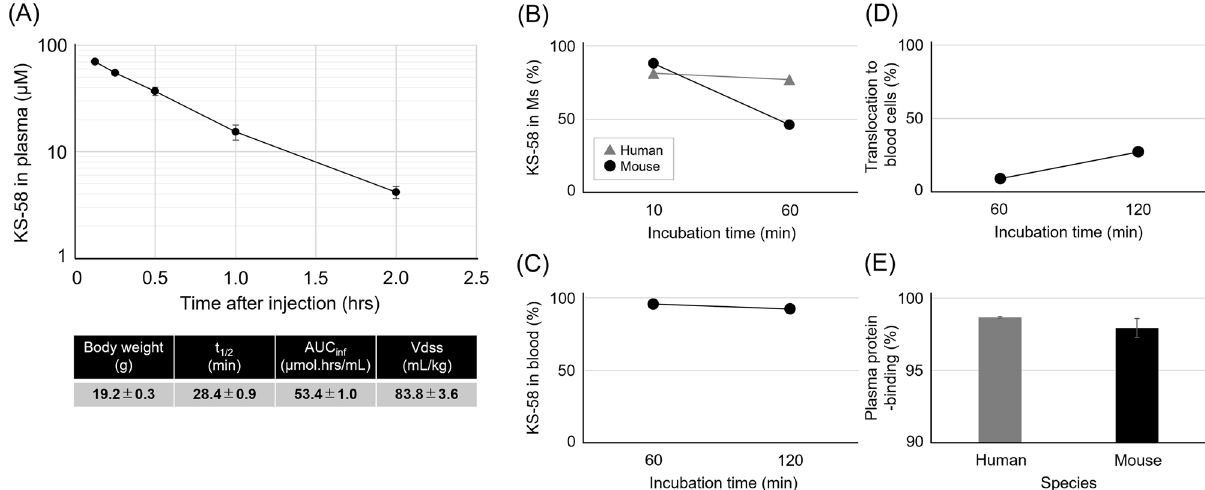
Figure 4. Pharmacokinetics and stability of KS-58. ( A ) KS-58 was intravenously injected at 10 mg/kg (n = 3 mice) and blood samples were collected at the indicated times. The concentration of KS-58 (mean ± SD) in plasma was determined by LC–MS/MS and the pharmacokinetics parameters t 1/2 , AUC inf , and Vdss were calculated as described in “Materials and methods” section. ( B ) KS-58 remaining in human and mouse liver microsomes (Ms) following 10 and 60 min of incubation. ( C ) Residual KS-58 in mouse whole blood after 60 and 120 min of incubation. ( D ) Translocation of KS-58 to blood cells. ( E ) Binding (%) of KS-58 to human and mouse plasma